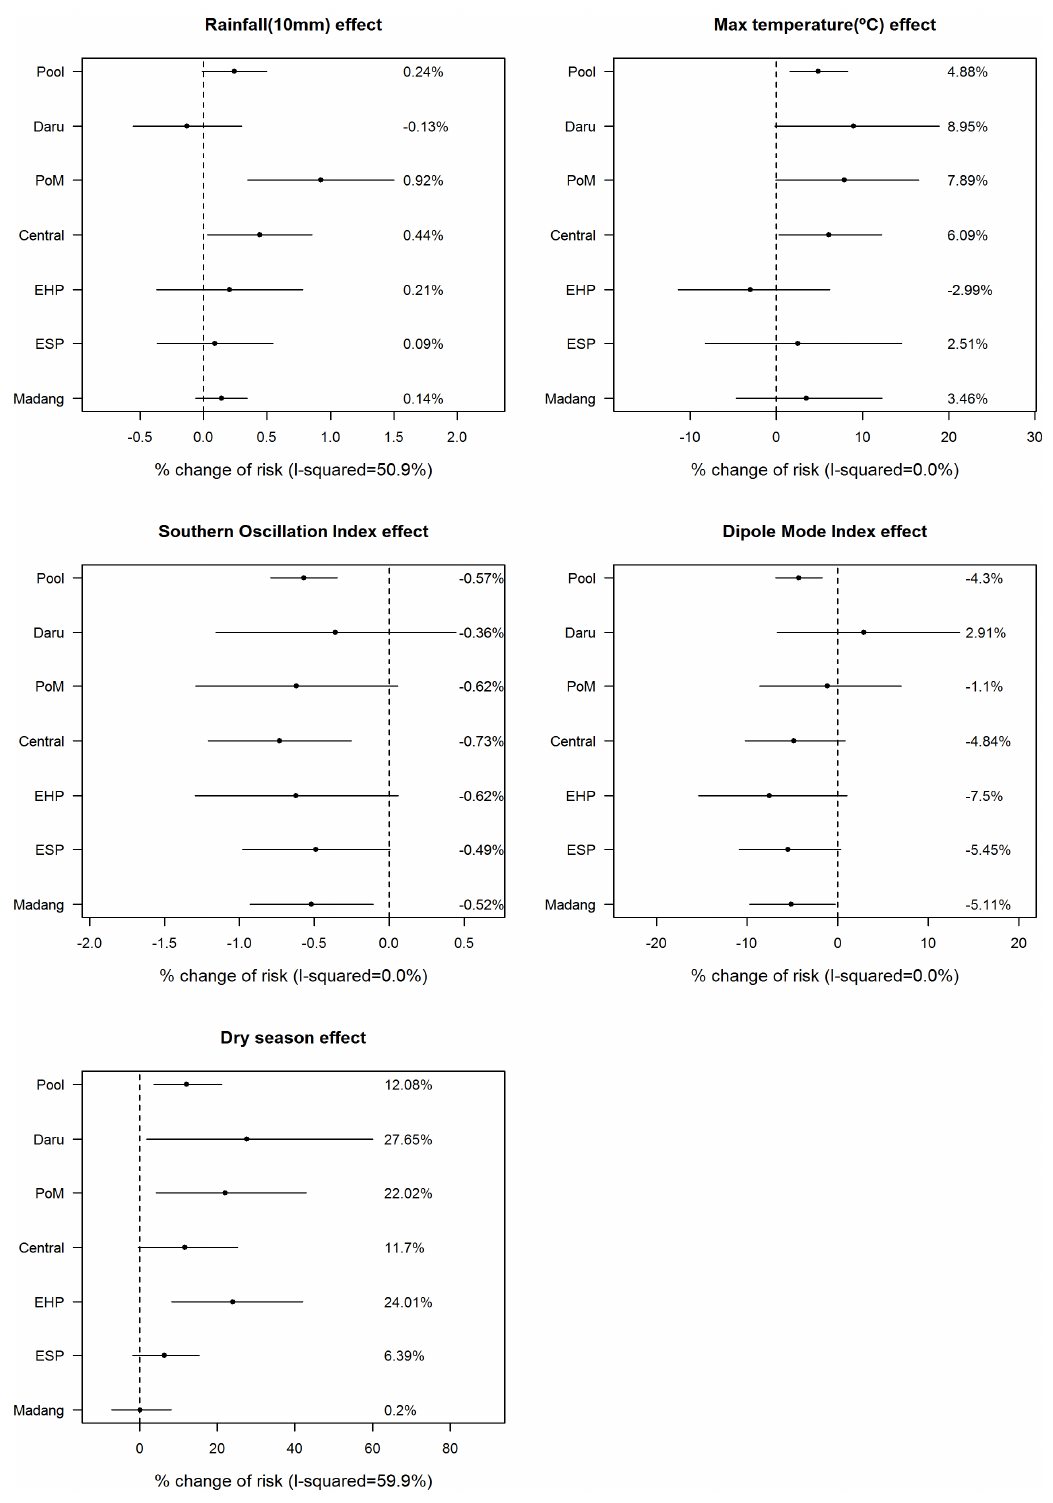
Figure 4. Percent change of risk and meta-analysis in six regions in Papua New Guinea PoM: Port Moresby, EHP: Eastern Highland Province, ESP: East Sepik Province.